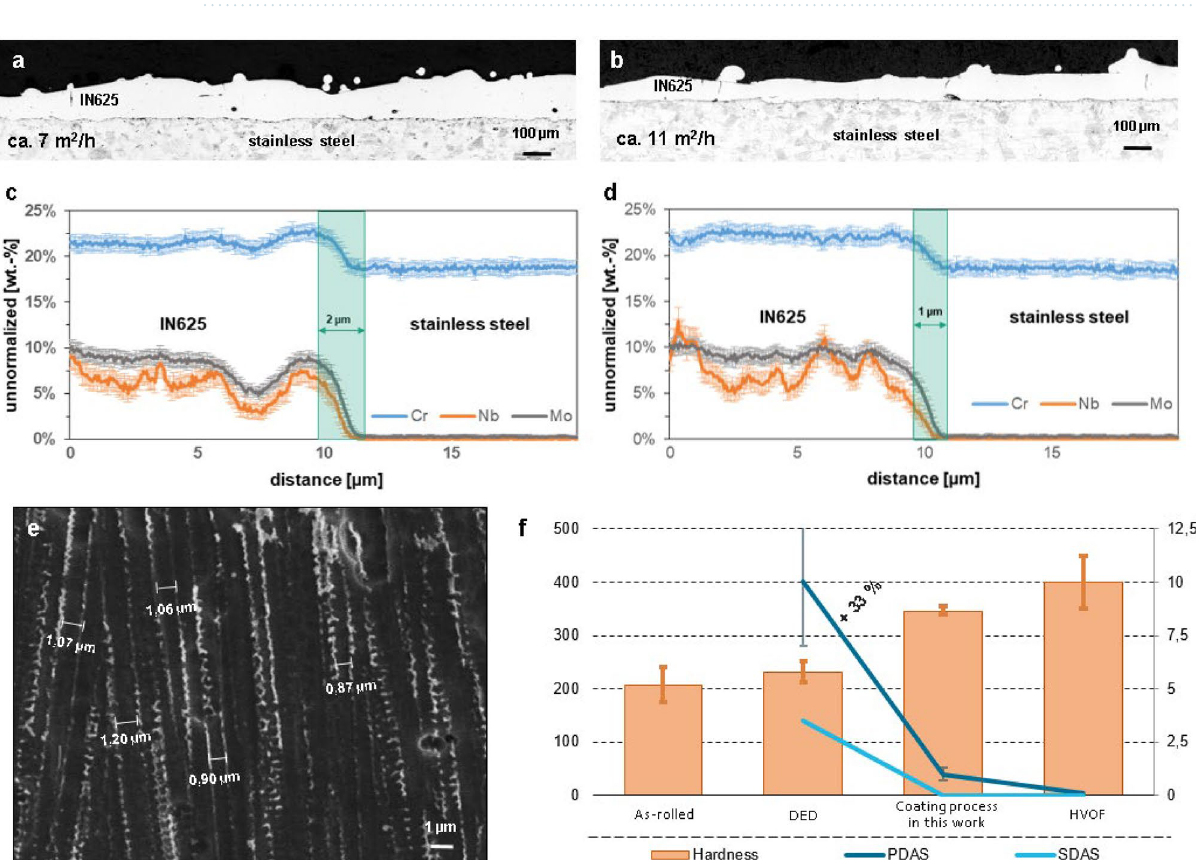
Figure 3. The metallurgical properties, the microstructure, and the hardness of the coatings. ( a , b ) The cross- sections of the coatings with an area coating rate of approx. 7 m 2 /h and 11 m 2 /h, respectively. ( c , d ) The results of WDS-analysis of the coatings with an area coating rate of approx. 7 m 2 /h and 11 m 2 /h, respectively. According to the results, a dilution depth of about 2 µm and 1 µm in depth are achieved for both coatings, respectively. ( e ) A scanning electron microscopy (SEM) micrograph showing the finer microstructure of the coated IN625, where some of the primary dendrite arm spacing (PDAS) are measured. ( f ) The hardness, the PDAS and the secondary dendrite arm spacing (SDAS) of IN625 produced by different processes are compared. It can be seen, the hardness of our process is significantly higher than that of raw material. It is comparable to that of HVOF and is about 33% higher than that of